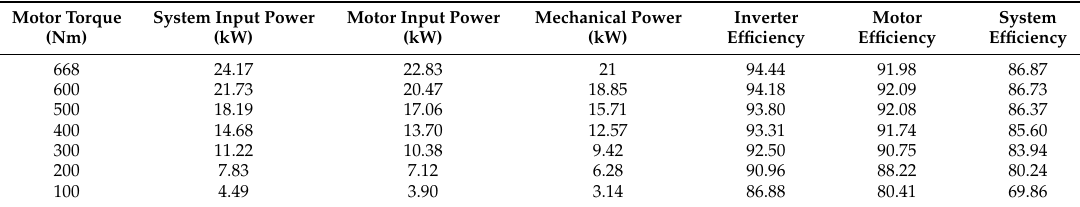
Table 4. Experimental results in the rated speed by the MTPA control.